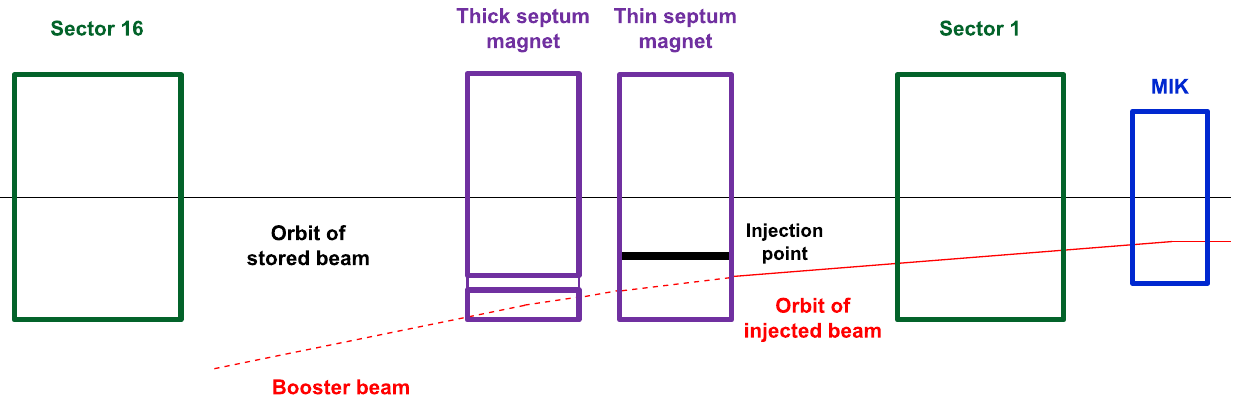
FIG. 4. MIK injection scheme. The orbit of the stored beam is left unperturbed (black solid line), while the booster beam (red dotted line) is brought close to the septum blade thanks to the septum magnets (in purple). The injected beam propagates freely (red solid line) until the amplitude of the horizontal oscillation is minimized by the MIK (blue square).